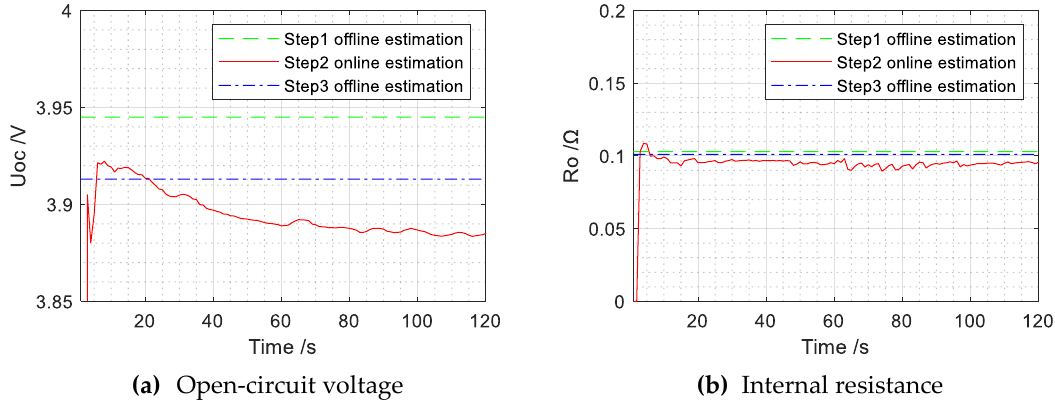
Figure 7. The trajectories of estimated battery parameters with sampling delay at 0 ms.